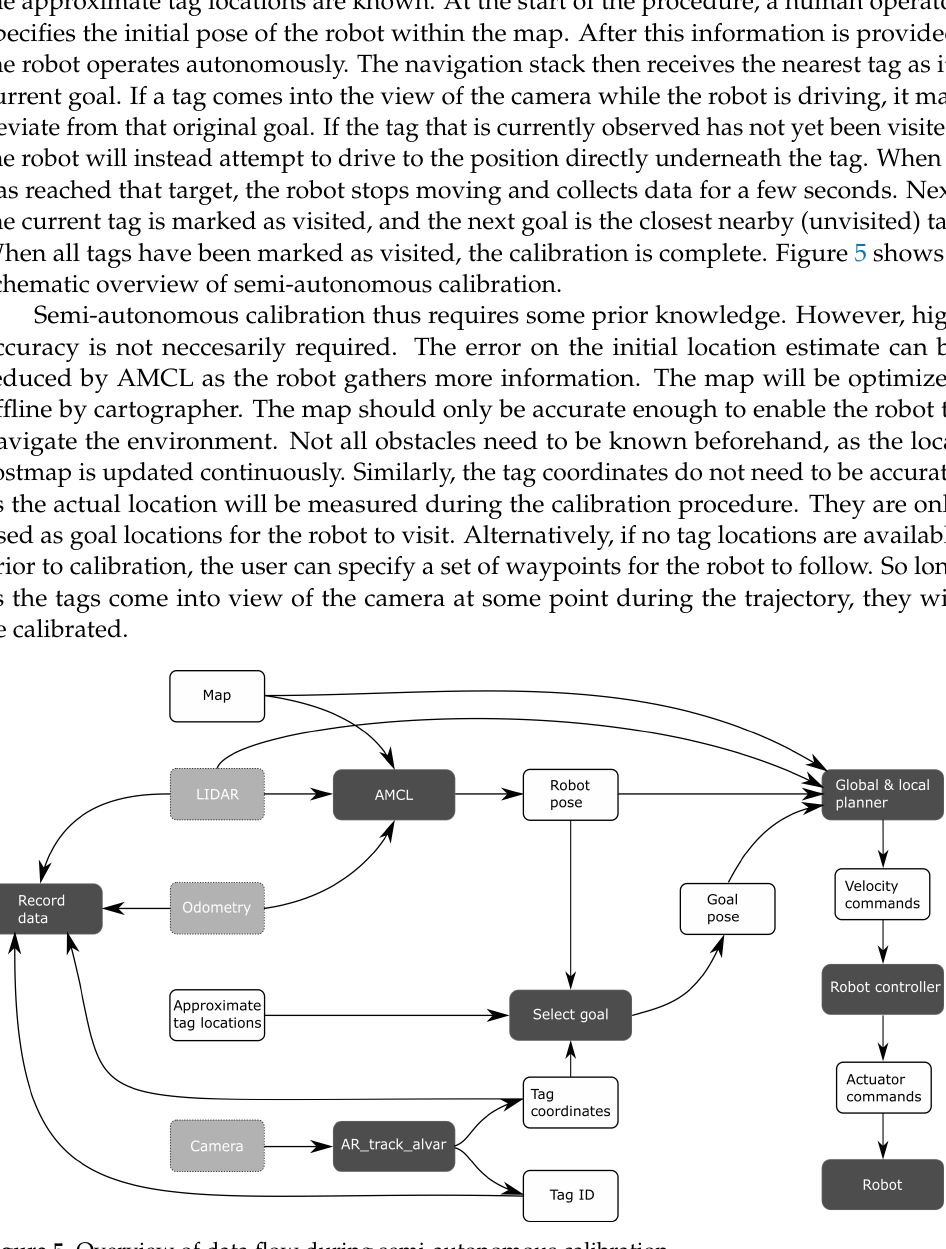
Figure 5. Overview of data flow during semi-autonomous